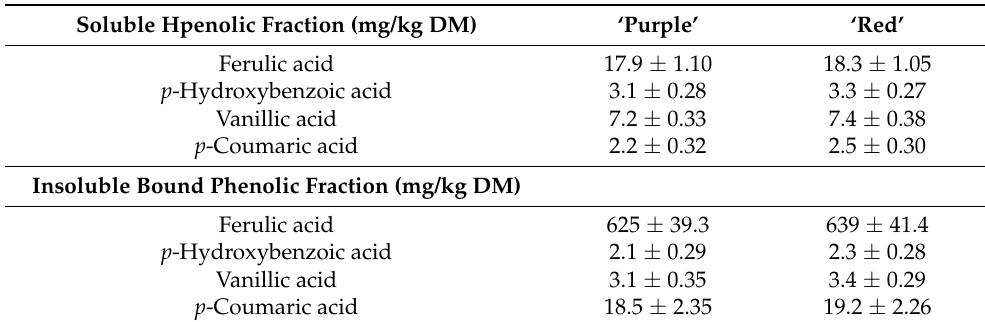
Table 3. Identification and quantification of the acids in the soluble and insoluble bound phenolic fraction in semolina of ‘Purple’ and ‘Red’ based on retention times and calibration lines for comparison with the corresponding commercial products. Values are reported as mean ± SD ( n = 5). Mean values between the two varieties were not statistically different ( t -test, p ≥